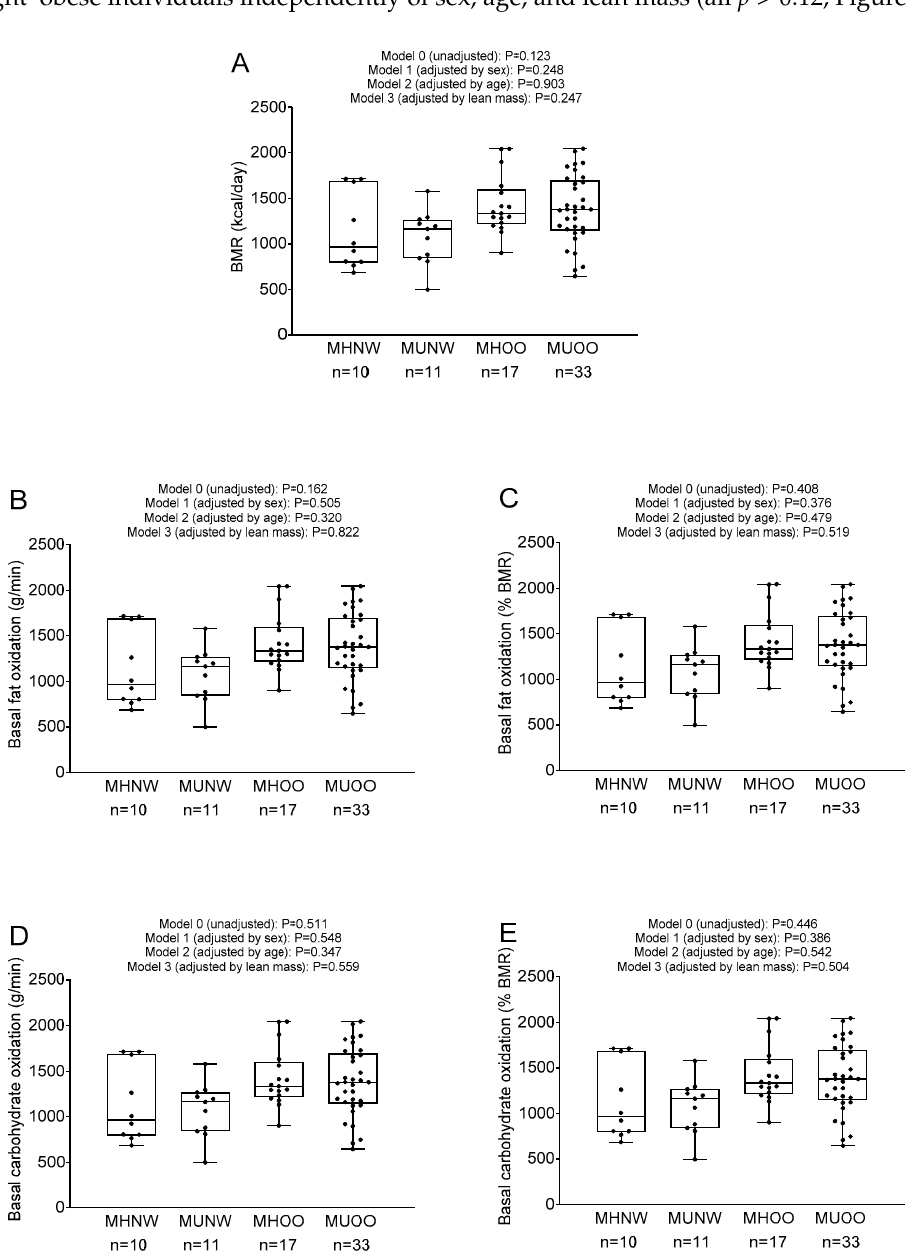
Figure1. ( A )Basalmetabolicrate(BMR),( B , C )basalfatoxidation, and( D , E )basalcarbohydrateoxidation in metabolically healthy normal-weight (MHNW), metabolically unhealthy normal–weight (MUNW), metabolically healthy overweight–obese (MHOO), and metabolically unhealthy overweight–obese (MHOO) participants. P from analysis of variance (Model 0) and analysis of covariance (Model 1: adjusting by sex; Model 2: adjusting by age; Model 3: adjusting by lean mass).